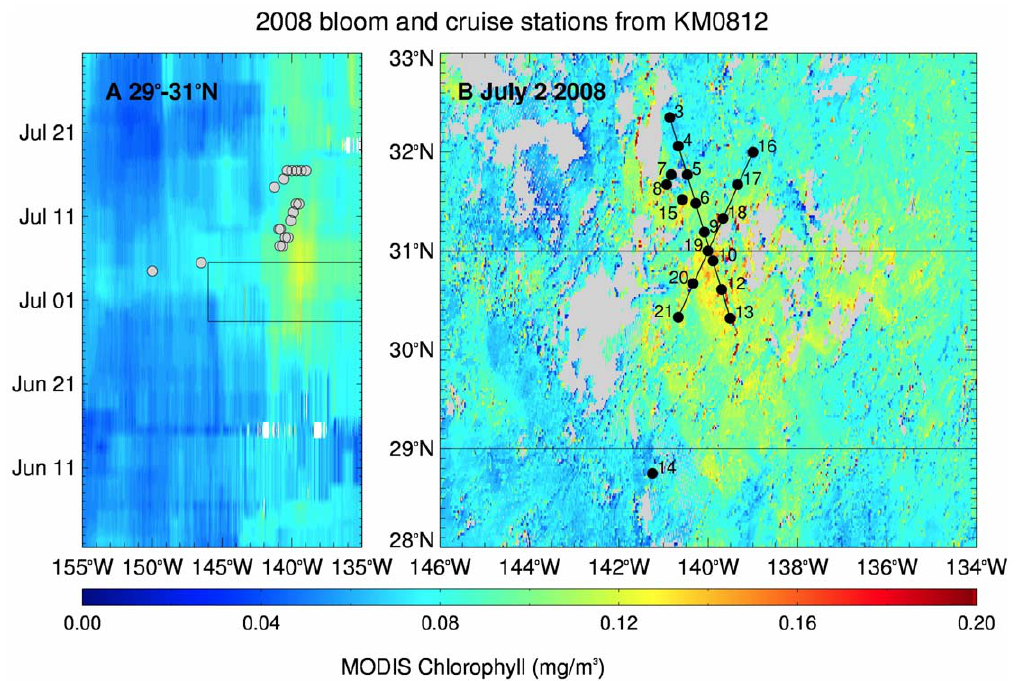
Figure 2. Satellite chlorophyll a estimate with overlying stations for 2008. (a) Hovmo¨ller diagram of MODIS chl showing the development of the 2008 bloom and (b) an 8-day composite showing the maximum extent of the chlorophyll bloom, overlaid with station locations. The black lines on (a) depict the temporal and longitudinal extent of the data shown in (b), and the black lines on (b) depict the latitude range of the data shown in (a). The image is an 8 day composite centered on July 3, 2008. Stas. 1 and 2 (see Table 1) are off the map. Transect 1 (Sta 3–15), Transect 2 (Sta. 16– 21).